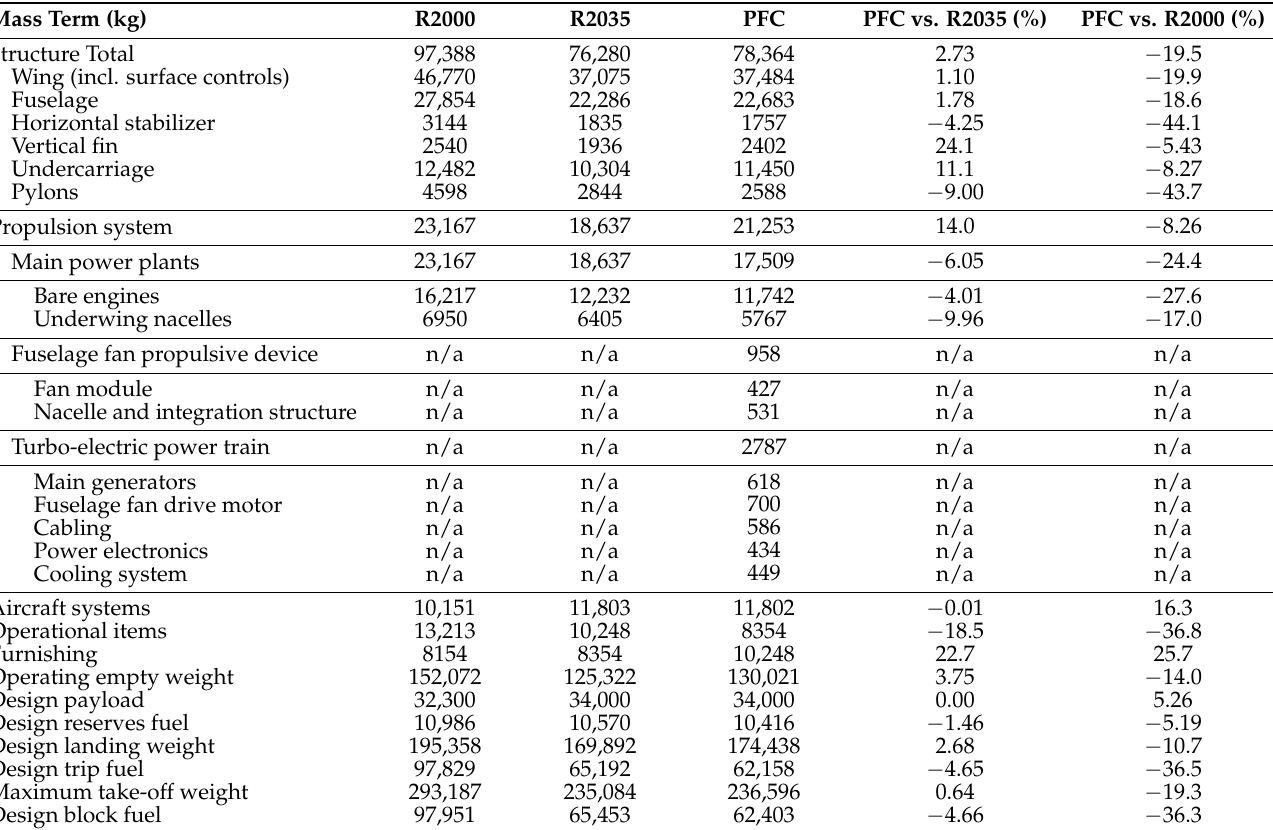
Table 16. Mass breakdowns of the CENTRELINE R2000, R2035 and PFC baseline aircraft